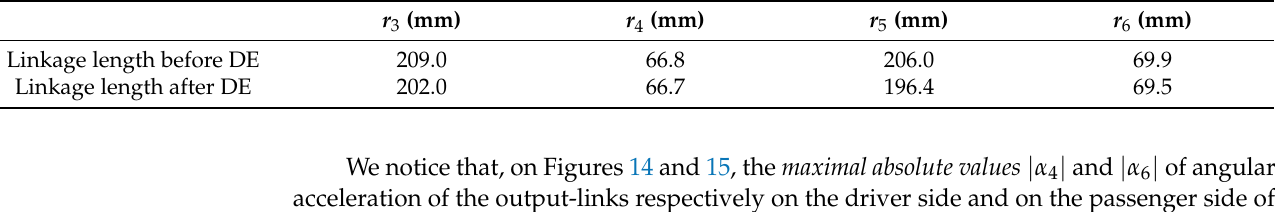
Figure 13. C omparison of our modeling computation with that of ADAMS on 6  .